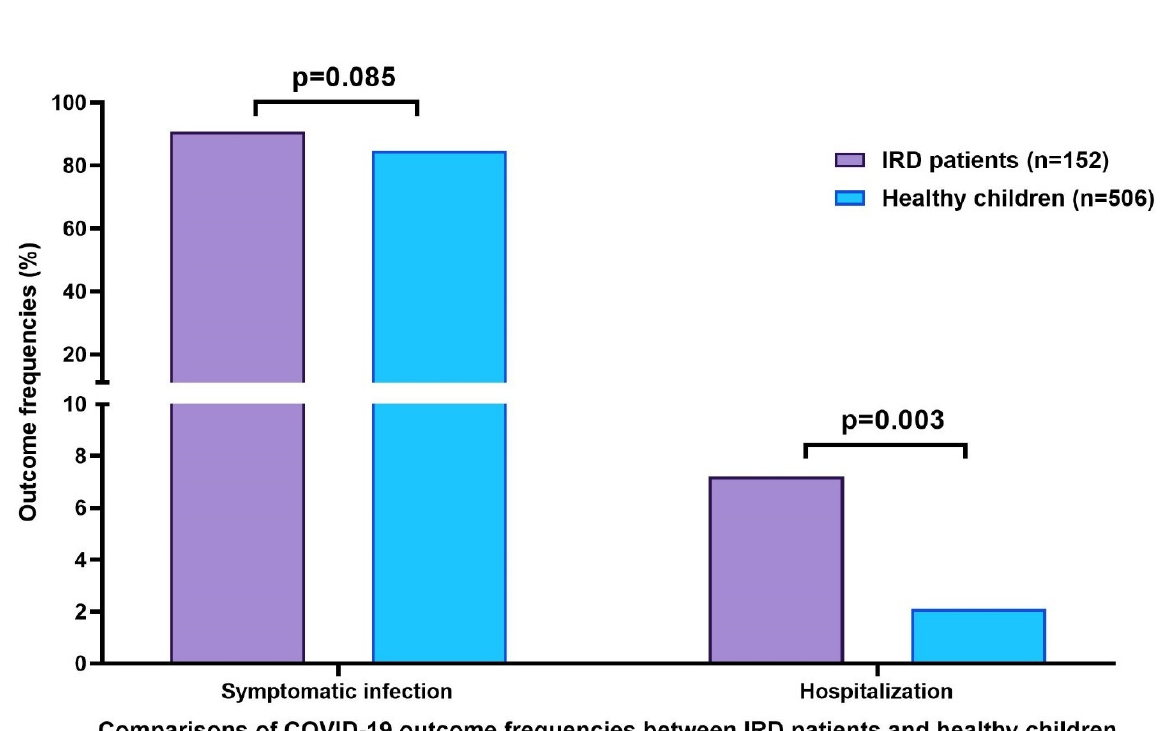
Figure 2. Comparisons of outcomes and clinical features of IRD patients and healthy children.